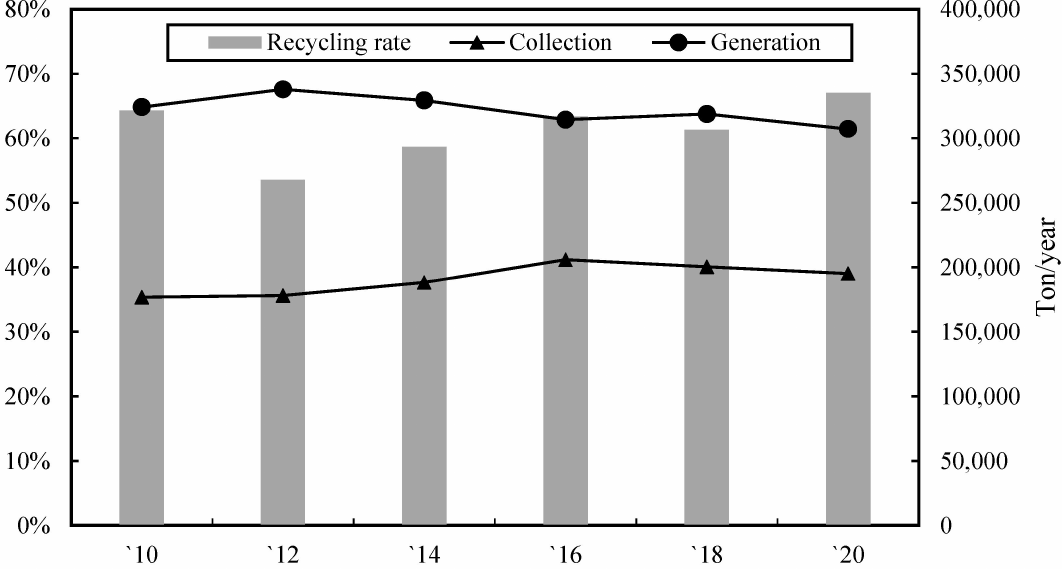
Figure 3. Current status of collection and recycling of AWV